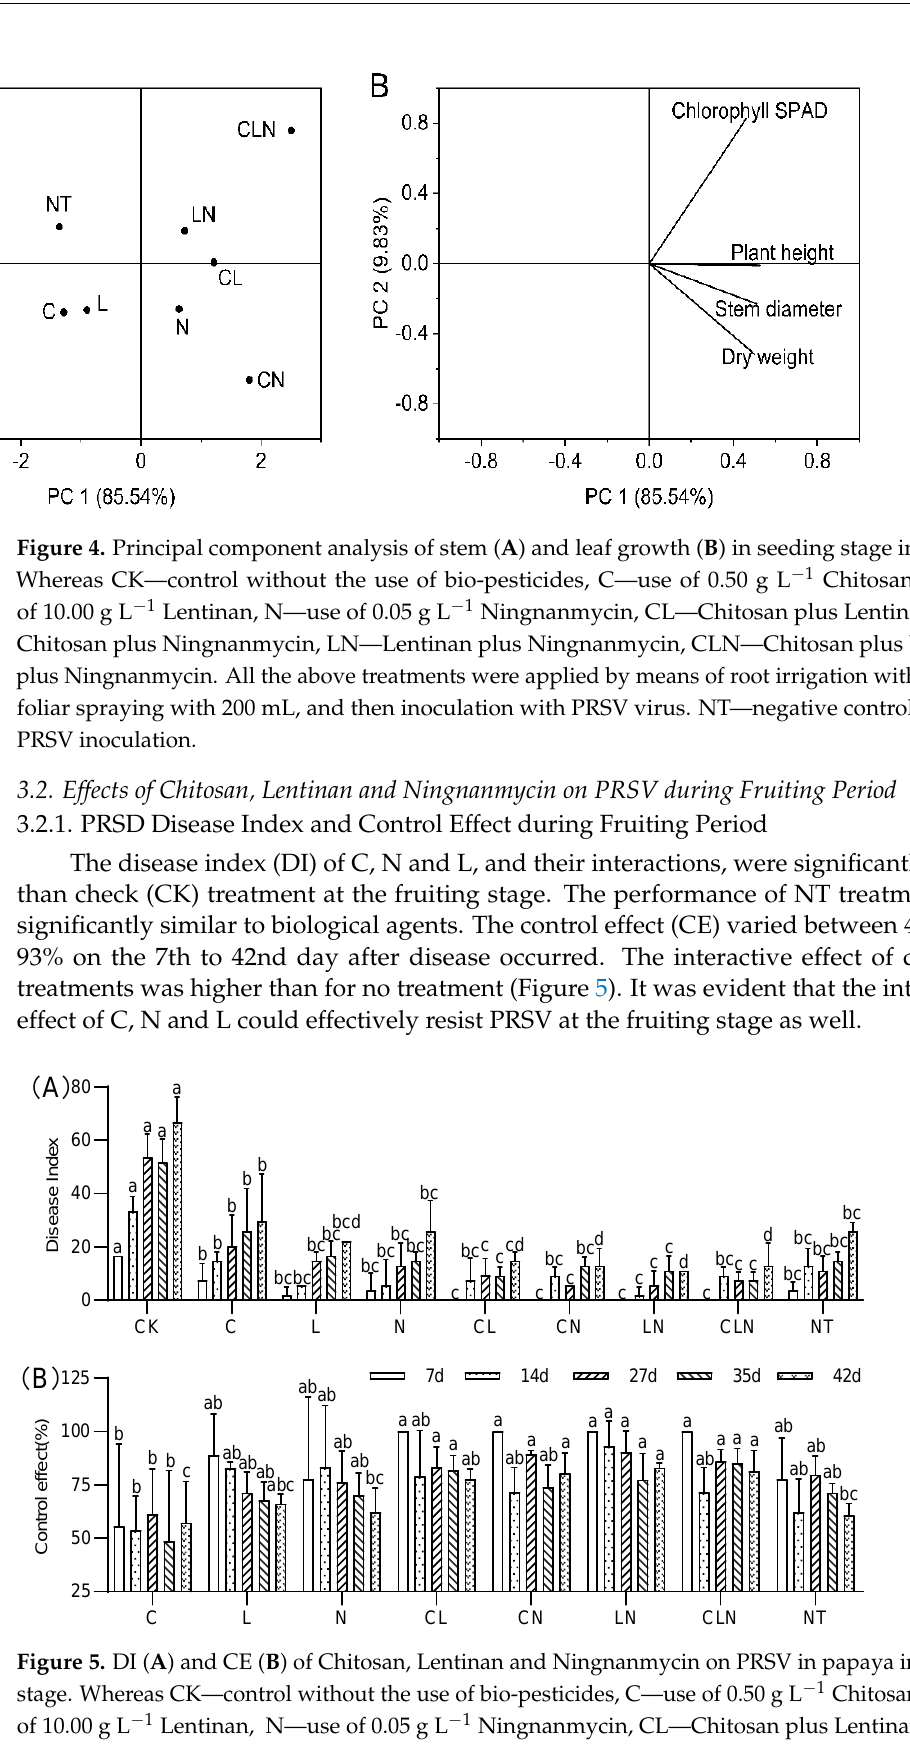
Figure 5. DI ( A ) and CE ( B ) of Chitosan, Lentinan and Ningnanmycin on PRSV in papaya in fruiting stage. Whereas CK—control without the use of bio-pesticides, C—use of 0.50 g L −1 Chitosan, L—use of 10.00 g L −1 Lentinan, N—use of 0.05 g L −1 Ningnanmycin, CL—Chitosan plus Lentinan, CN—Chitosan plus Ningnanmycin, LN—Lentinan plus Ningnanmycin, CLN—Chitosan plus Lentinan plus Ningnanmycin. Each papaya plant was irrigated with 5 L and sprayed with 6 L biological pes- ticide once every 7 to 14 days. NT—negative control without PRSV inoculation. Different lowercase letters indicate significant differences at the 0.05 level.